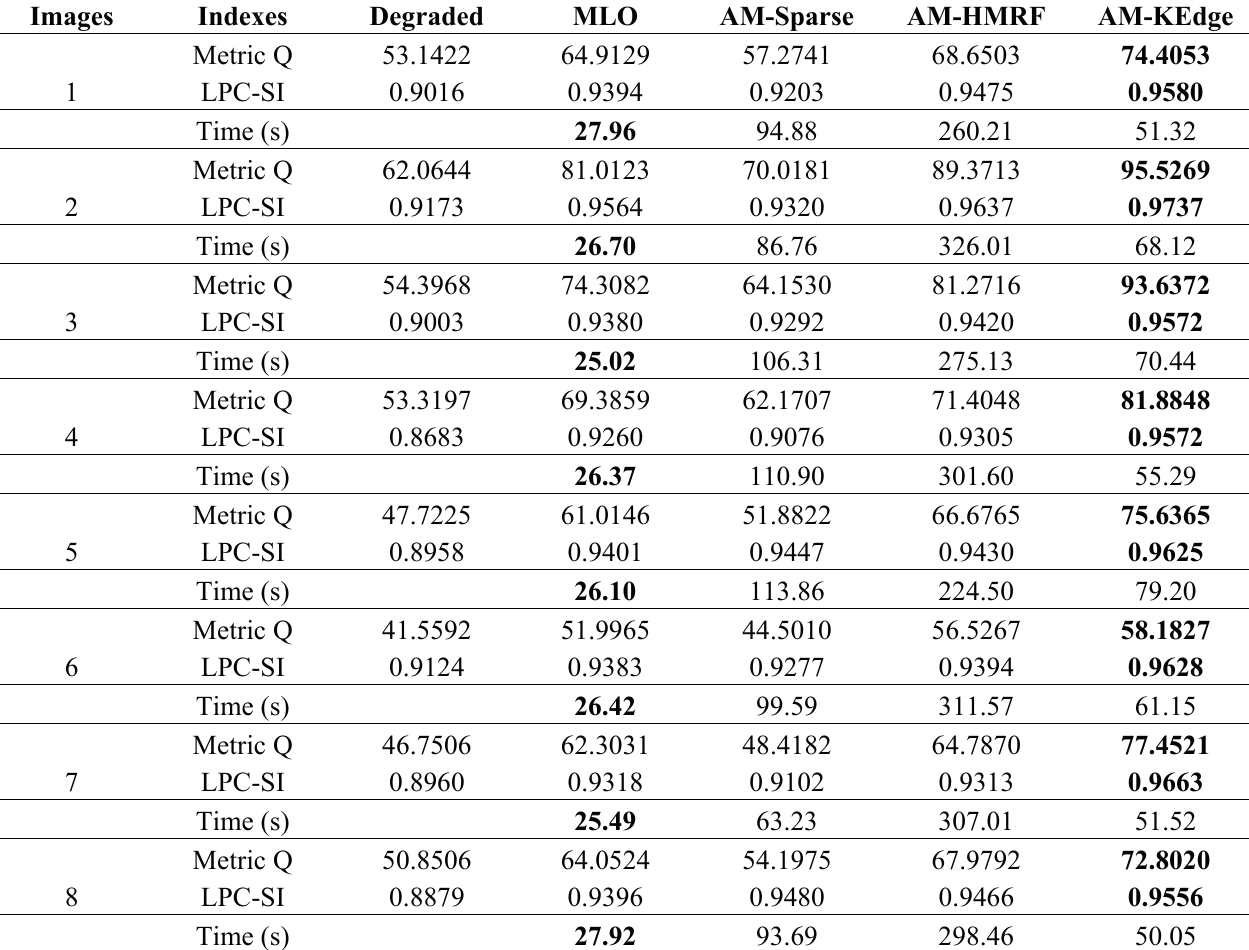
Table 2. Metric Q and local phase coherence-based sharpness index (LPC-SI) results and the computation times in the real data